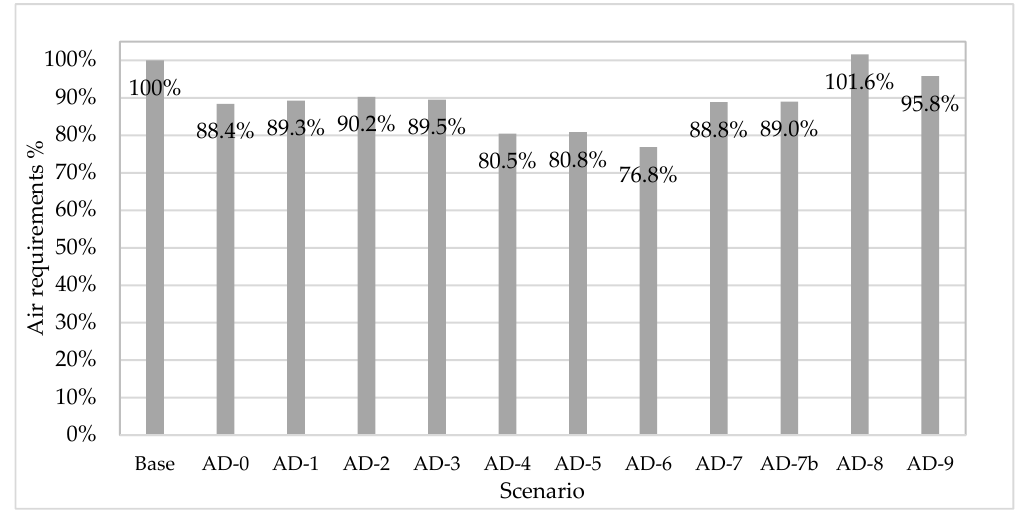
Figure 3. Comparison of the air requirement per year for the tested strategies.